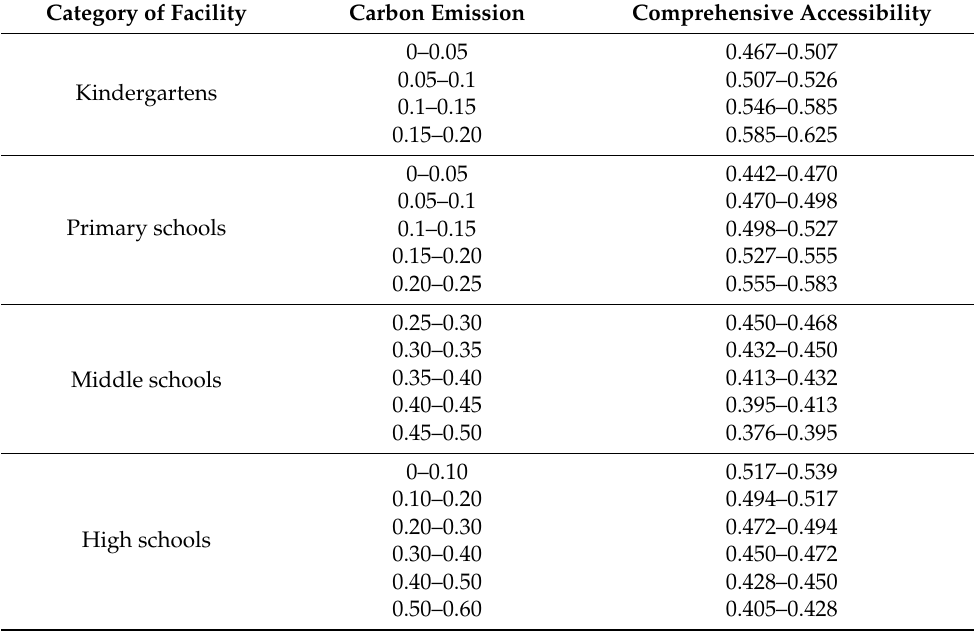
Table 18. Corresponding relation of comprehensive accessibility and education